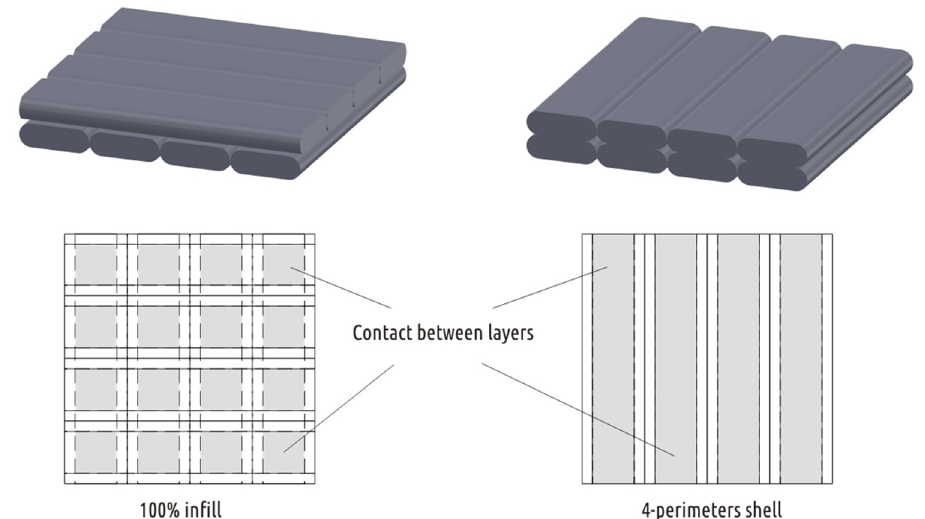
Figure 14. Superposition of polymer threads in adjacent layers of infill (left) and shell (right) and the contact area between the layers.